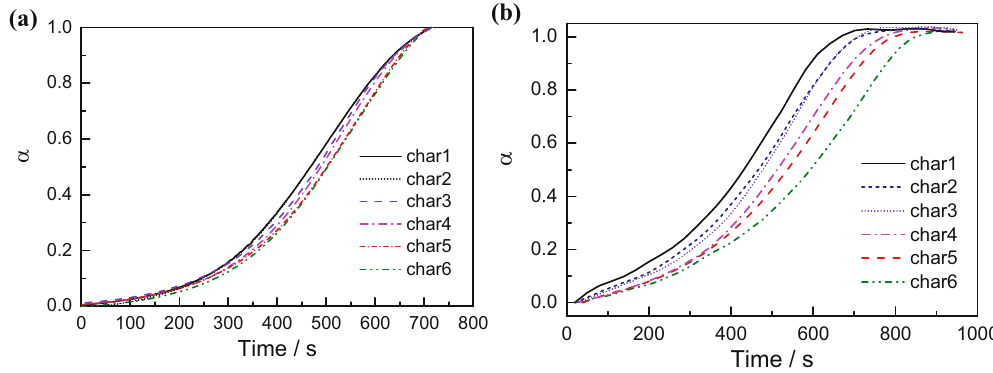
Figure 3: Time - dependent changes in carbon conversion rates of di ff erent semi - coke. ( a ) Air atmosphere; ( b ) CO 2 atmosphere.